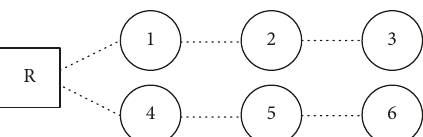
Figure 12: Multihop topology with two 3-hop network branches.